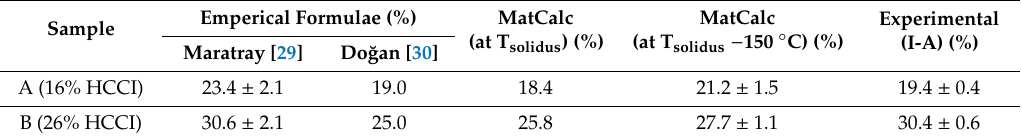
Table 3. Comparison between the % carbide volume fractions (CVFs) of both alloys obtained using different approaches.